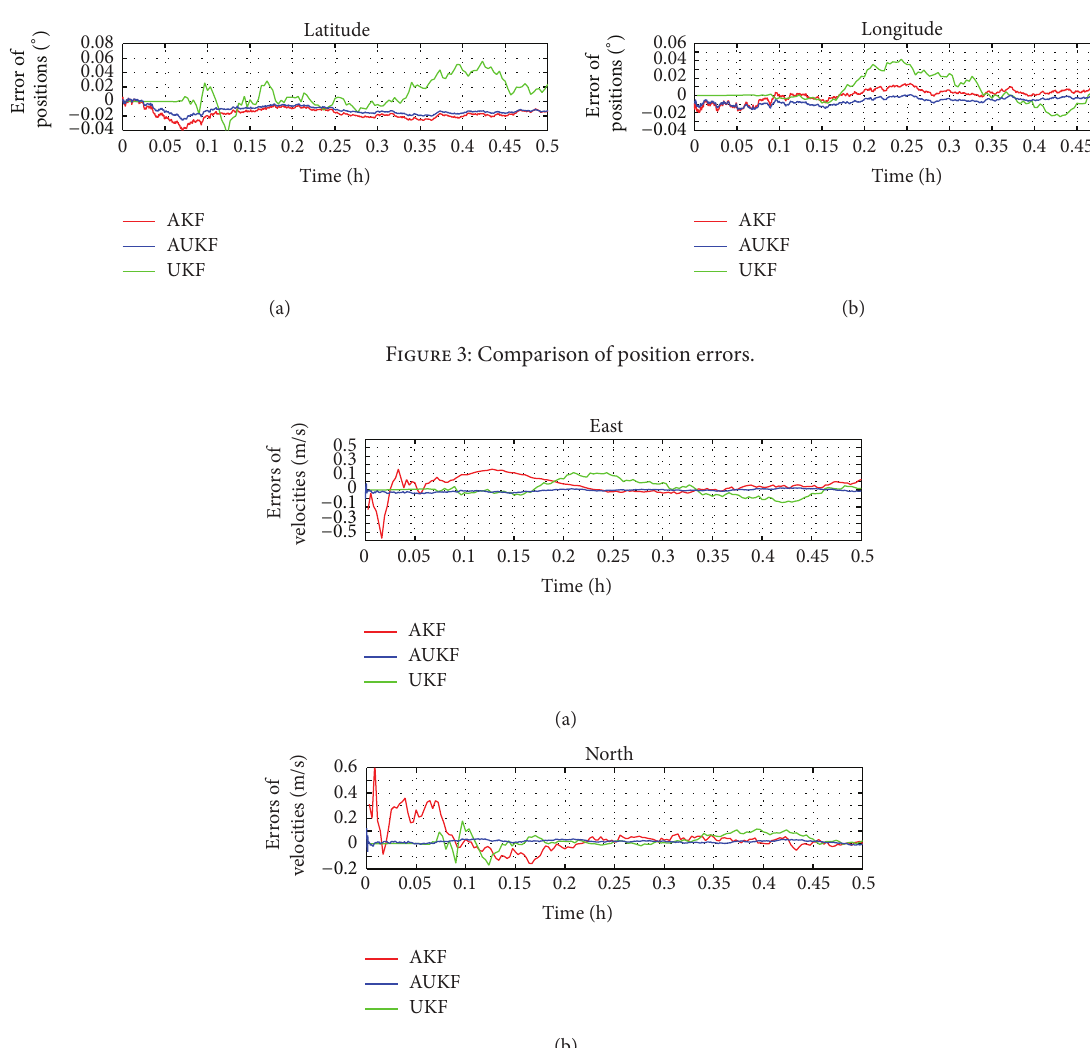
Figure 4: Comparison of velocity